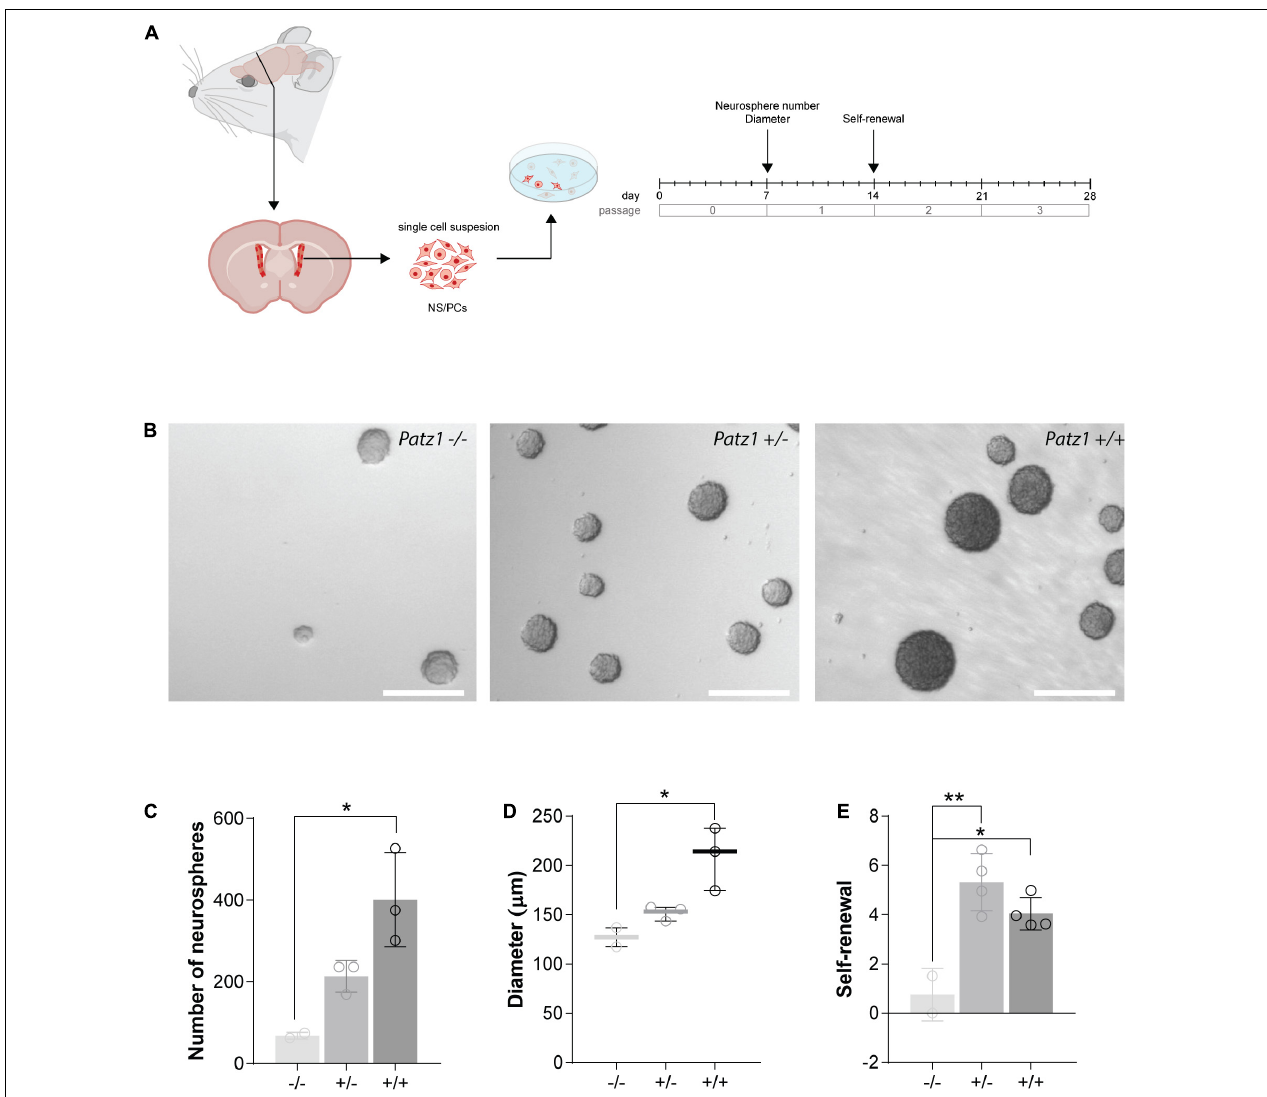
FIGURE 5 | Ex vivo proliferation assay of SVZ-derived NS/PCs from adult mice. (A) Experimental scheme showing the brain region microdissected to produce neurospheres and relative experiment timeline. (B) Representative images of neurospheres from Patz1 − / − , Patz1 + / − and wild type mice. Scale bars = 100 µ m. (C) Bar/dot plot (means ± SD) showing the number of primary neurospheres (P0) obtained from the adult brains by plating all the cells recovered by SVZ dissection. (D) Box dot/plot showing the diameter of the P0 neurospheres (median ± min to max). (E) Neurosphere self-renewal capacity (number of neurospheres of the first-generation (P1)/plated cells * 100). All the significant differences are indicated by asterisks. * P < 0.05; ** P < 0.01, as assessed by ANOVA followed by Tukey’s multiple comparisons